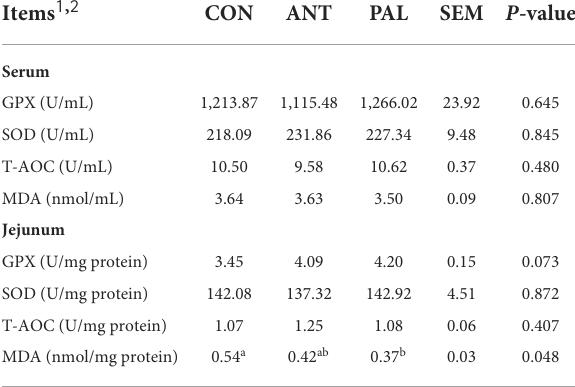
TABLE 5 Effects of dietary palygorskite supplementation on the plasma biomarkers of intestinal permeability and mucosal morphology of jejunum in